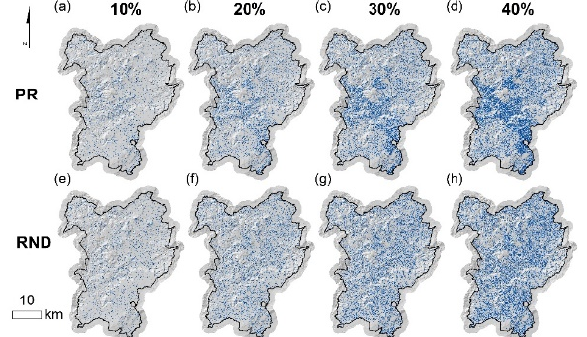
Figure 3. Maps of the abandonment units, considering two spatial patterns of land abandonment scenarios (priority (PR; a – d ), random (RND; e – h )), and 10, 20, 30, and 40% of agropastoral land abandonment. Blue polygons represent abandonment units.